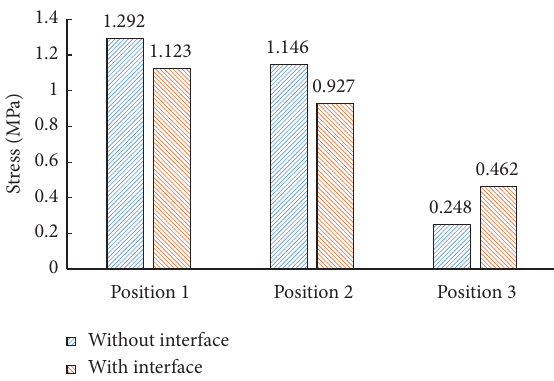
Figure 8: Histogram of stress at three key